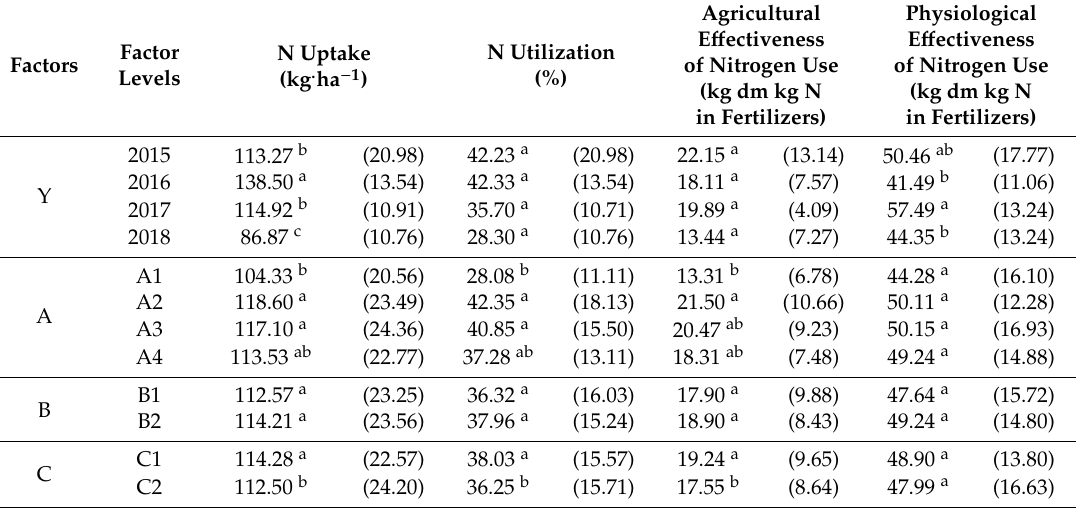
Table 4. Mean values and standard deviations (in brackets) of traits for years and other